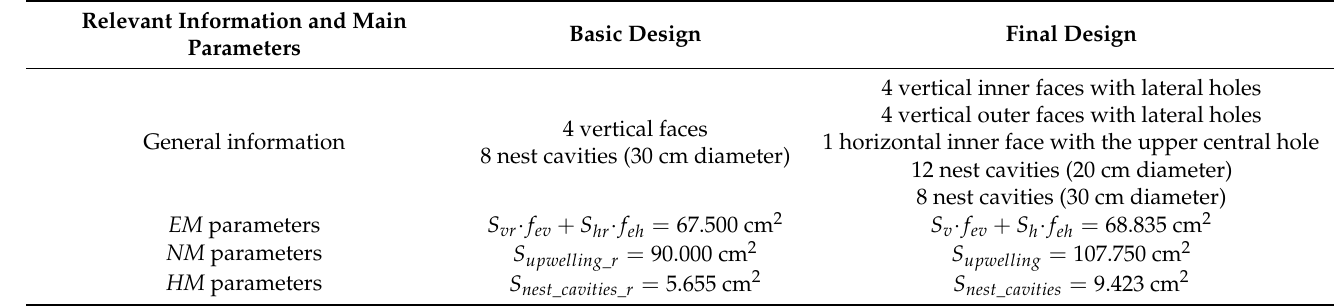
Figure 9. Results for the final AR design (left design, red colour) in comparison with the reference one (right design, yellow colour). This figure includes the value that each design presents for the three partial indices. Table 3. General information and relevant parameters for the final and reference AR unit